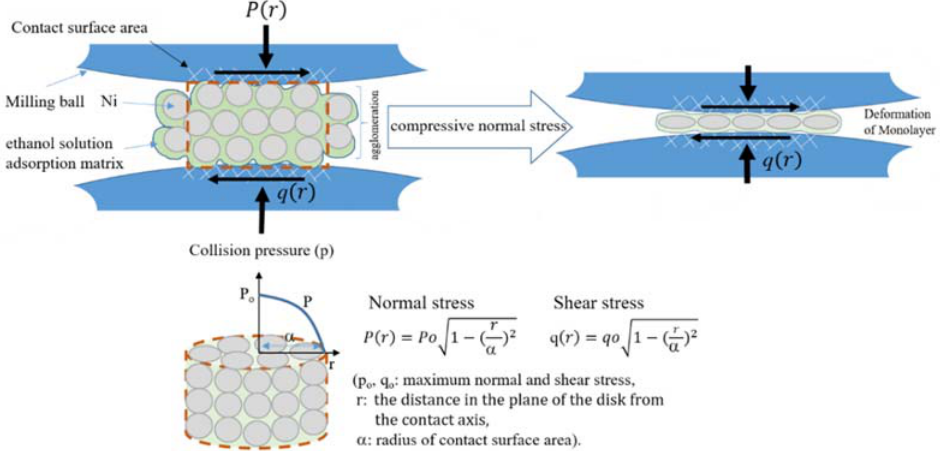
Figure 5. Schematic diagram showing the stress transfer over hypothetical Ni ‐ powder agglomera ‐ tion between the collision balls based on the modified Hertzian mechanics.